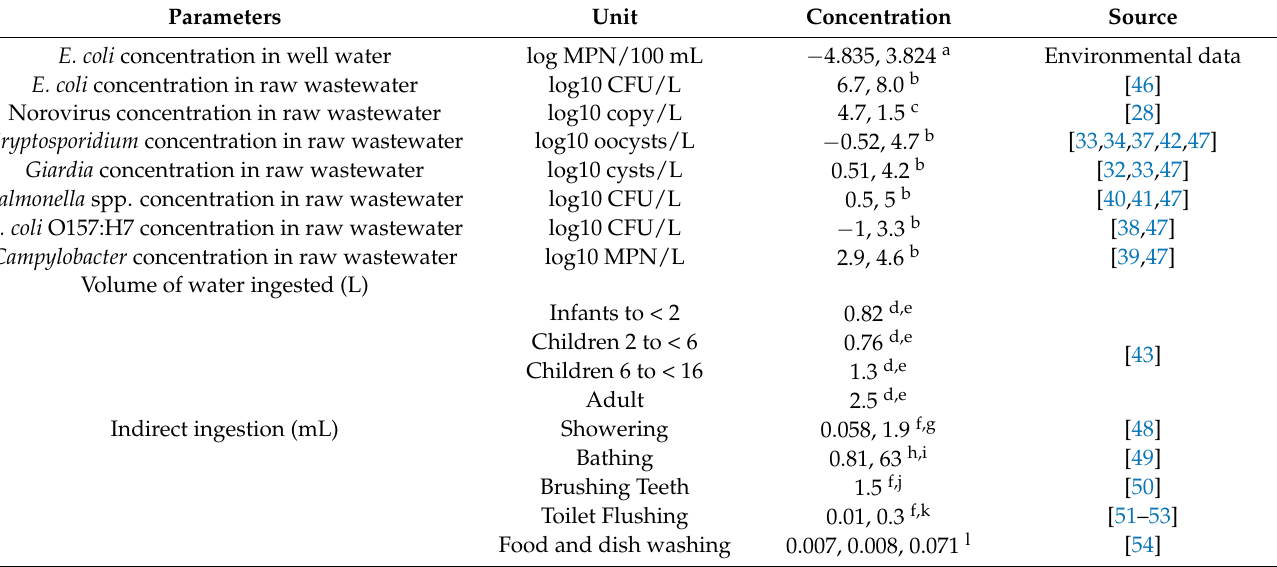
Table 1. Input parameters for Monte Carlo simulations regarding ingestion as an exposure scenario.